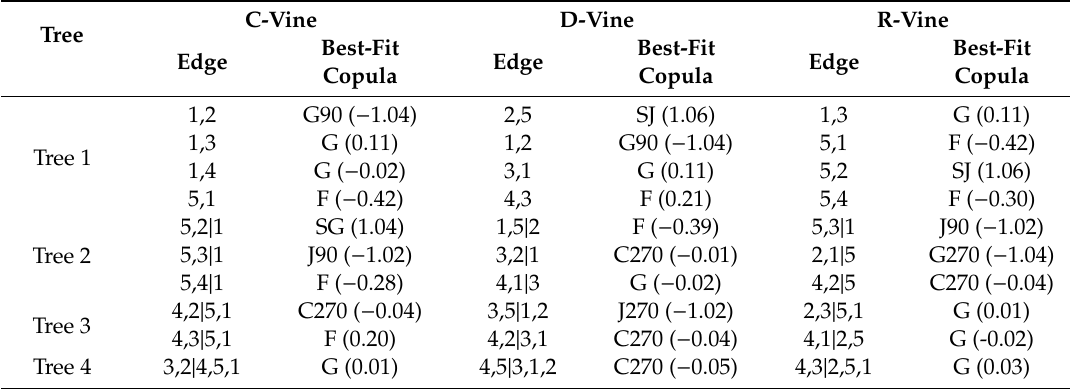
Table 5. The breakdown structures and best-fit copula families of three classes of vines in the period of A-IRSN.